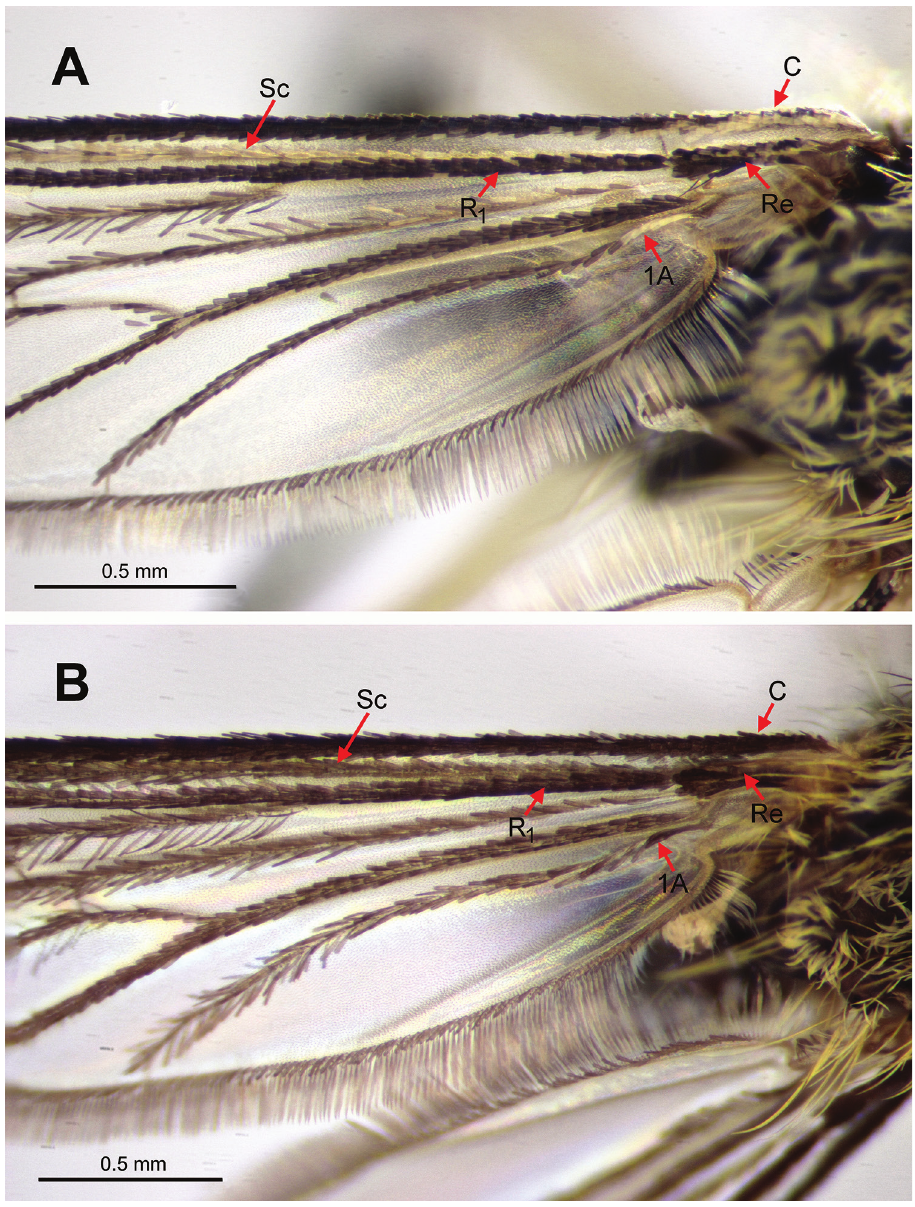
Figure 1. Proximal half of the right wing of female mosquitoes. A Ae. nigrinus , showing the presence of pale scaling on the costa, subcosta, remigium and anal vein B Ae. sticticus , showing the absence of pale